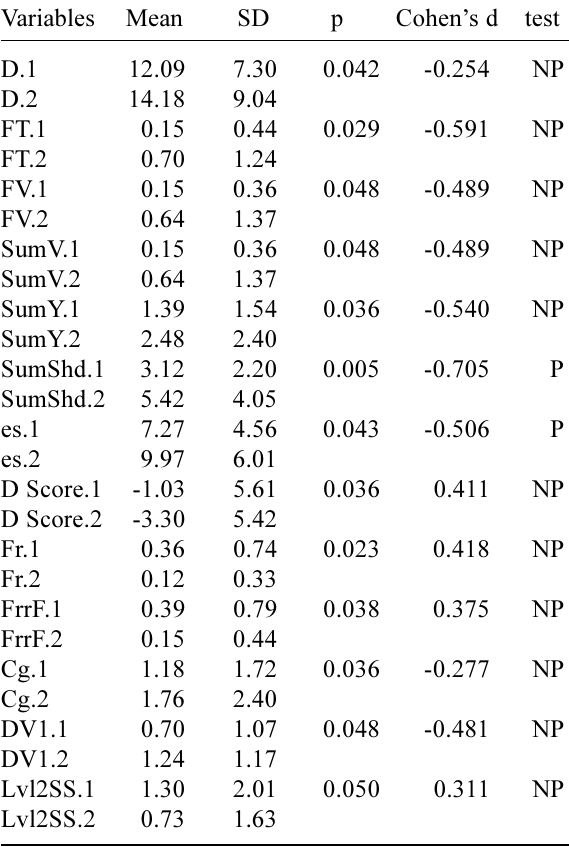
Statistics of the Rorschach Significant Variables on T1versus T2 of 33 Patients